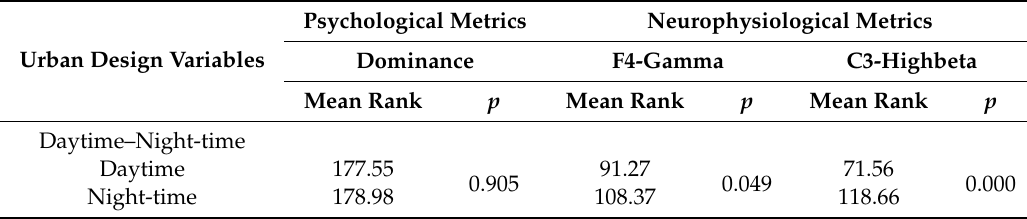
Table 7. Mann–Whitney U tests for the di ff erences in the mean ranks of the psychological and